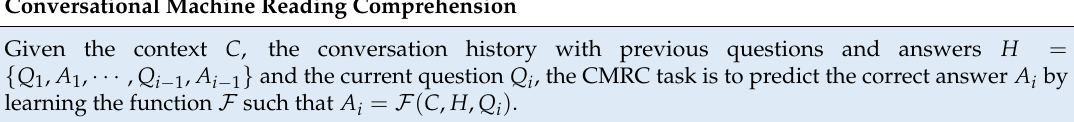
Table 14. Definition of conversational machine reading comprehension.